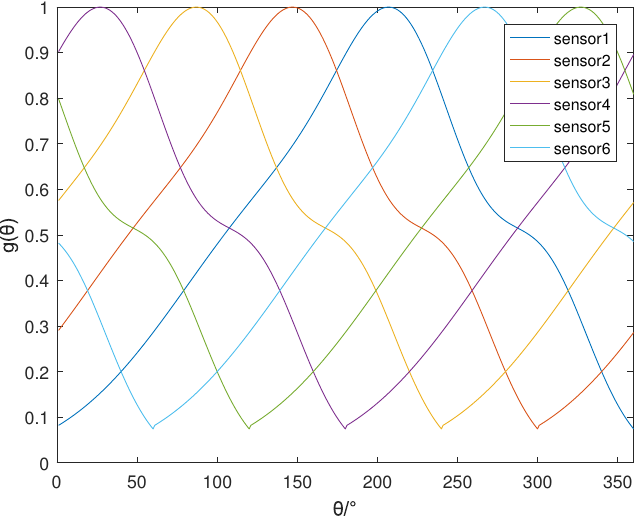
Figure 1. Normalized